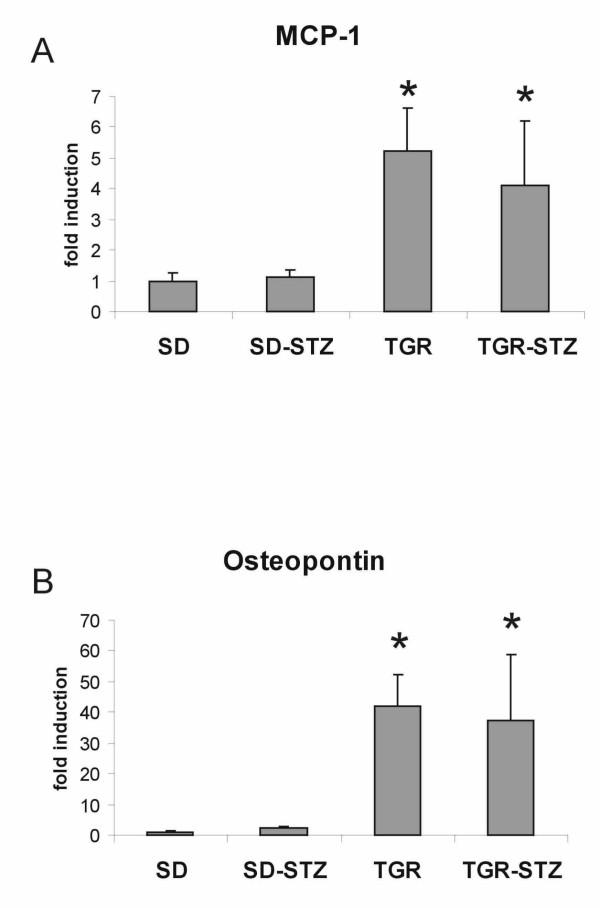
Real-time RT-PCR analysis of MCP-1 (A) and osteopontin (B) mRNA expression in the renal cortex. Data are expressed as fold control compared to SD control rats. Data are mean ± SEM of n = 5 rats. * indicates p < 0.05 versus normotensive normoglycemic SD control rats. SD, normotensive normoglycemic control rats; TGR, transgenic hypertensive rats; STZ, streptozotocin treatment.